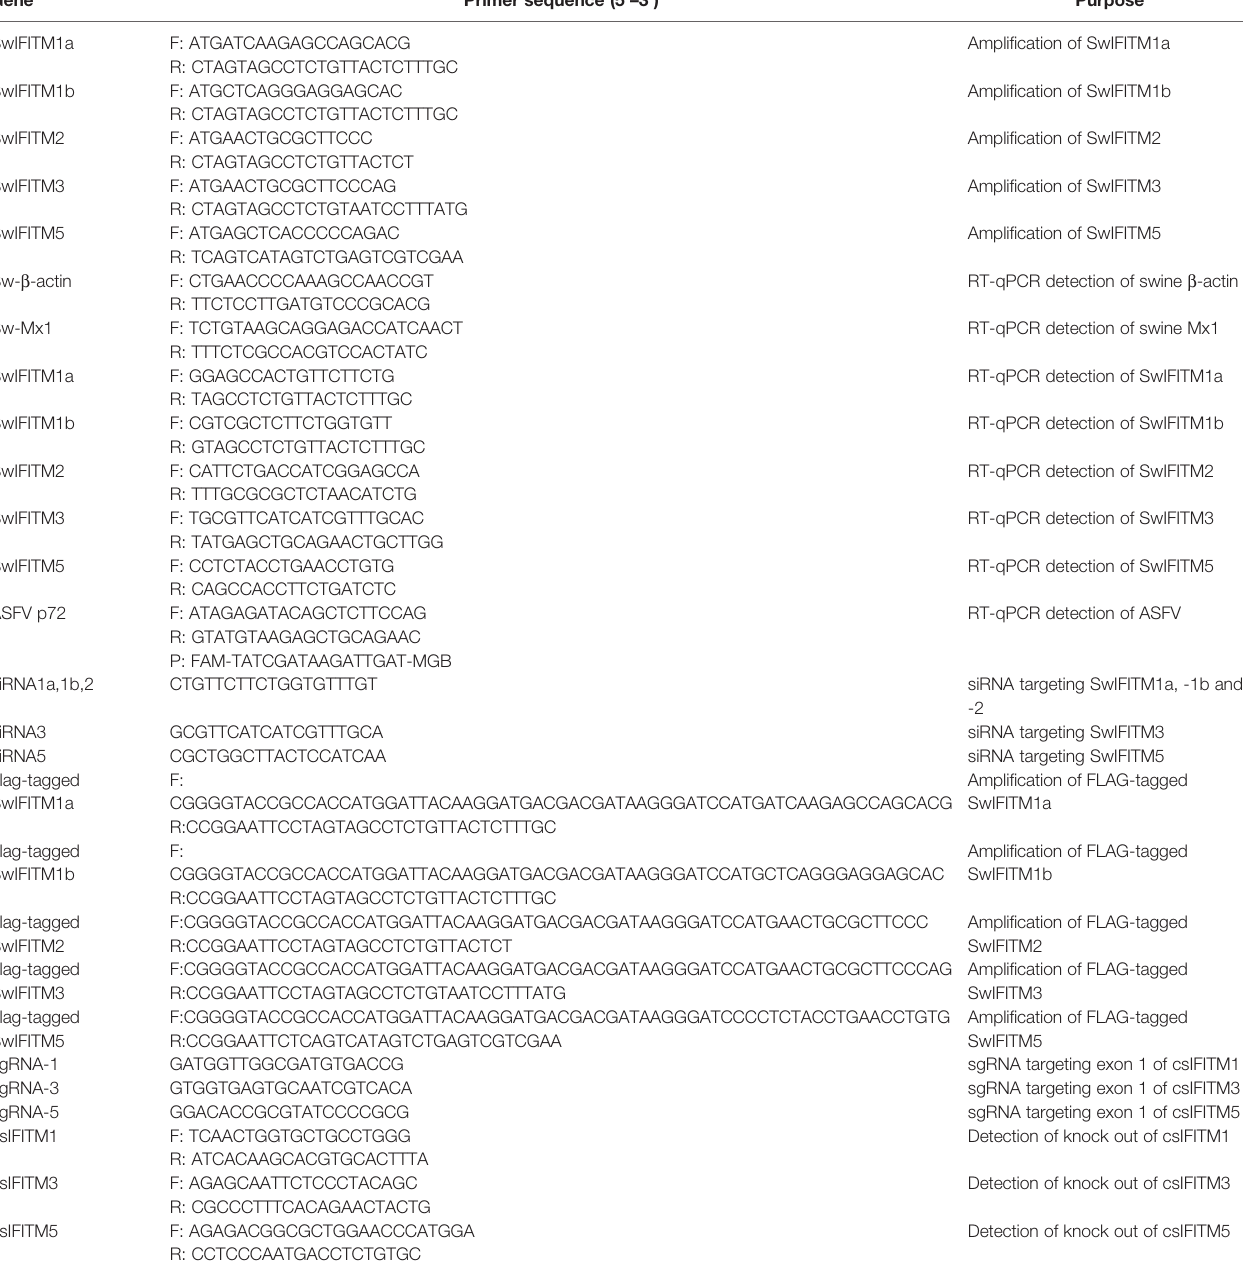
TABLE 1 | Primers used for gene cloning and RT-qPCR detection. Gene Primer sequence (5 ′ – 3 ′ )